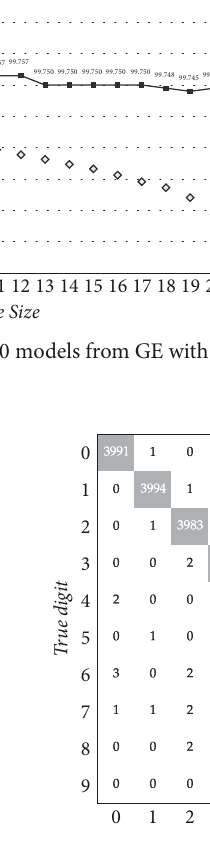
Figure 11: Confusion matrix of the best committee found for EMNIST Digits.